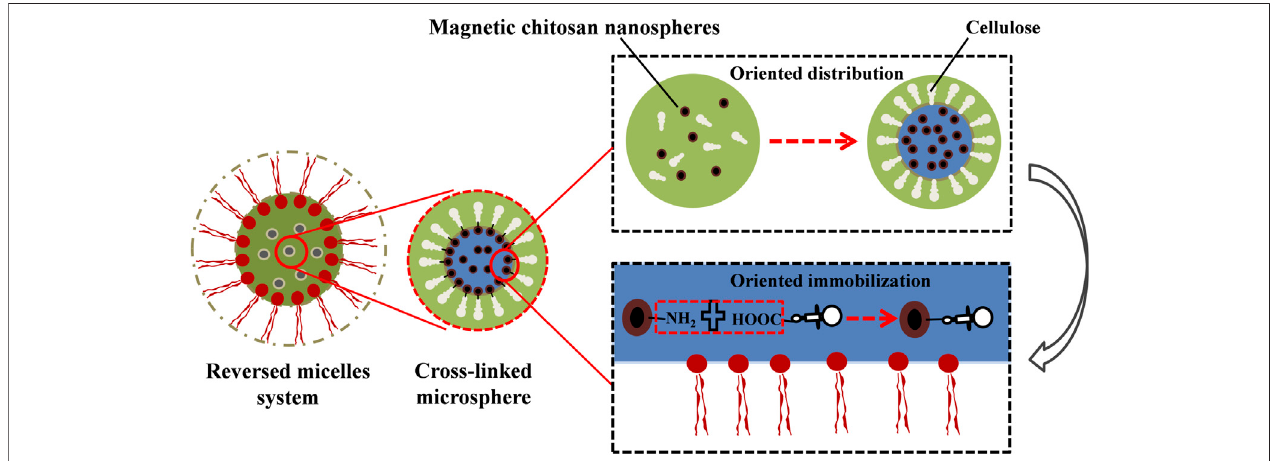
FIGURE3| Theorientedimmobilizationdiagrammaticsketchofsingle-layercellulaseinthesurfactantreversedmicellessystem,the “ green ” representstheinternal “ pool ” of SRM system, “ black ” represents the magnetic chitosan microspheres (C-MNPs), “ brown ” represents the cross-linked microsphere.